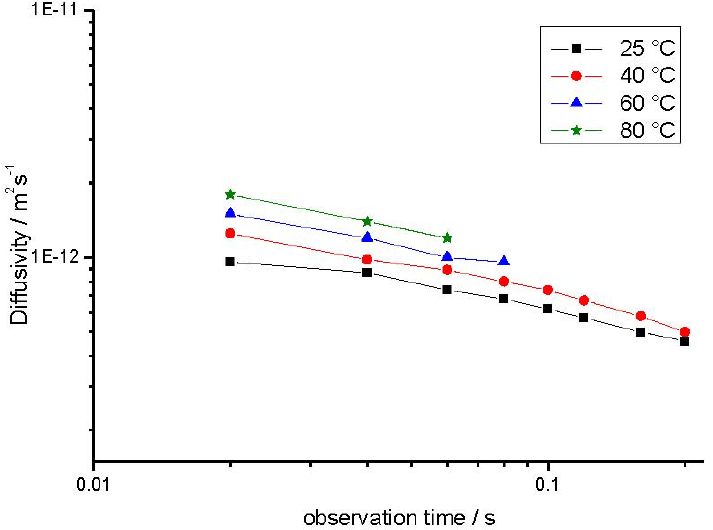
Figure 7. Effective intracrystalline diffusivity (Equation (13)) of propane in NaCa-LTA-0 as a function of the observation time t obtained at different